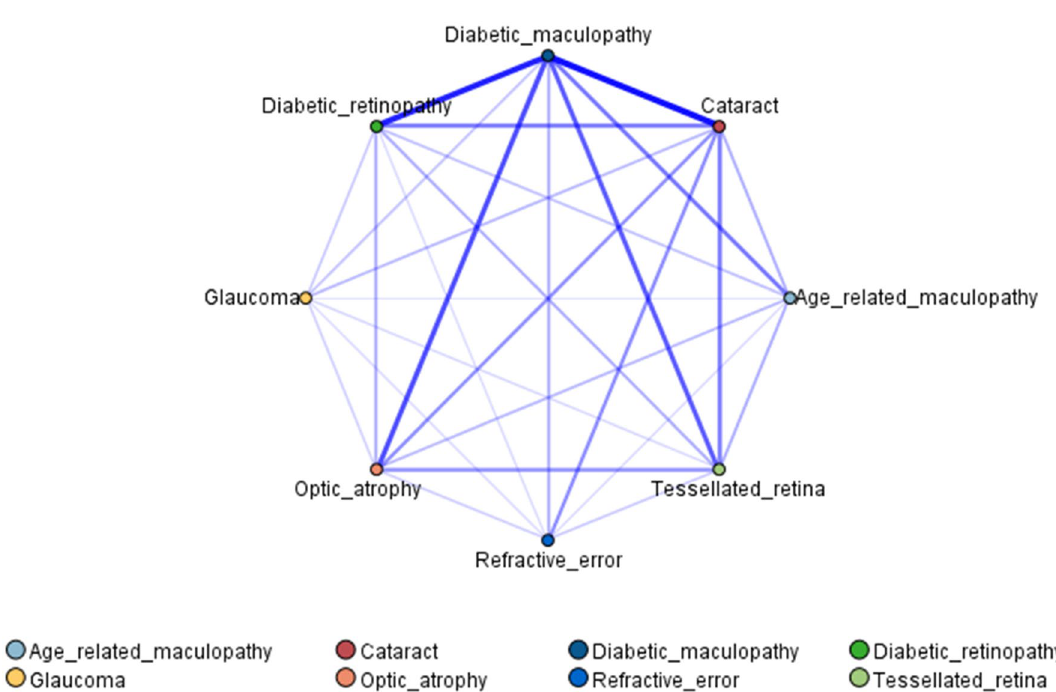
Figure 3. Web visualization network diagram of eye diseases in DM